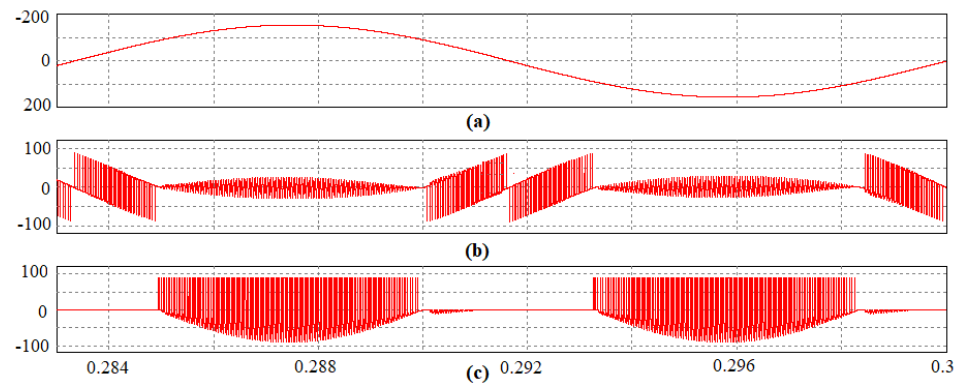
Figure 9. Voltages across L S and L 1 in a power grid cycle, ( a ) power grid voltage, ( b ) voltage across L S , ( c ) voltage across L 1 .